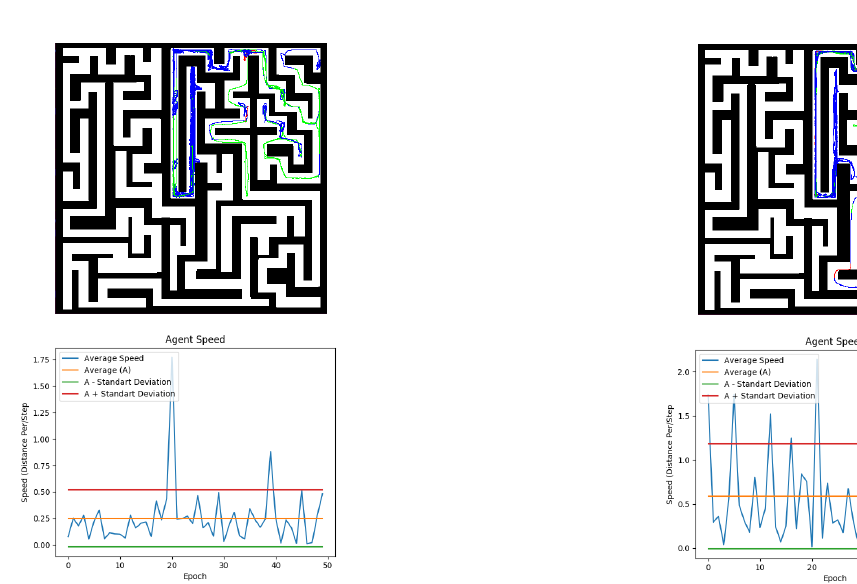
Figure 18. (a) The agent emotional state, and (b) the agent speed with the emotional model’s configurations equal to that shown in row 5 of Table